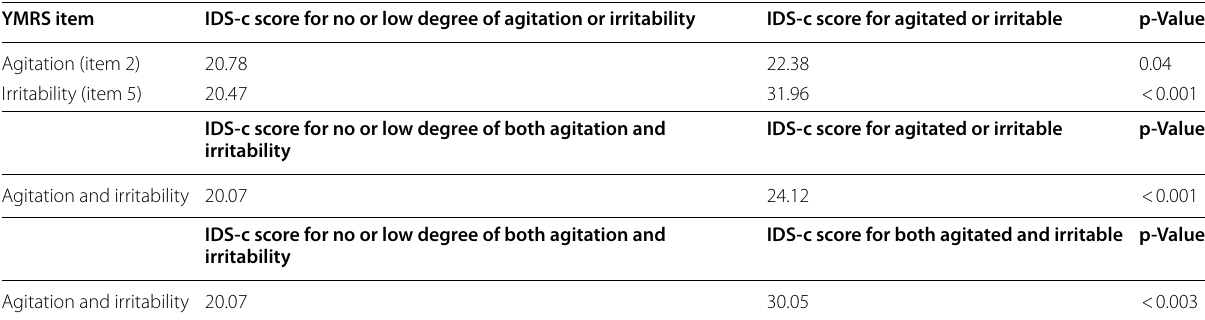
Table 6 Scoring high on YMRS item 2 (Agitation) or/and 5 (Irritability) predicted more severe depression in (hypo)manic subjects YMRS